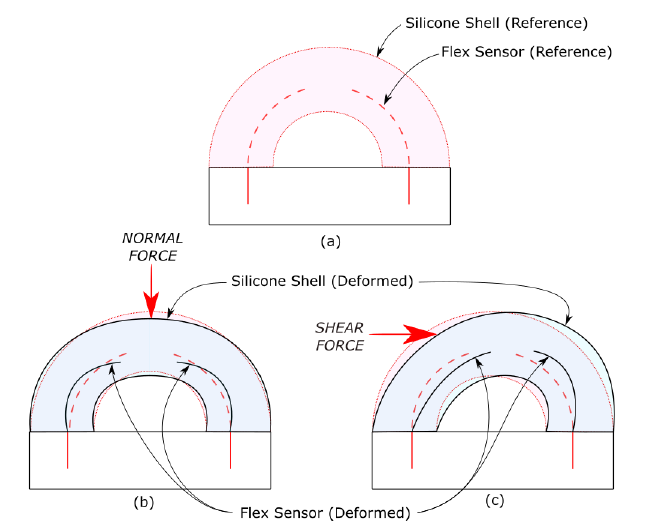
Figure 4. Representation of normal and shear force phenomena: ( a ) original position with no contact force, ( b ) deformed position with normal force, and ( c ) deformed position with shear